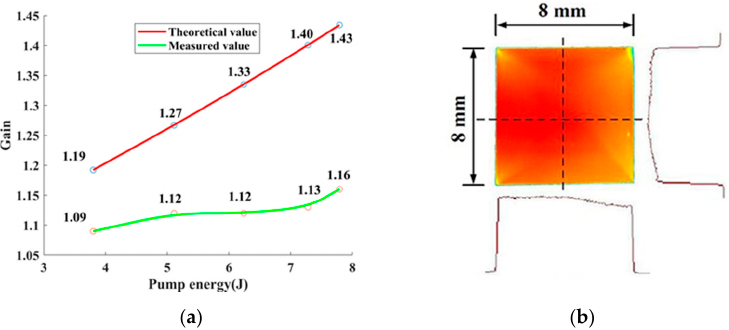
Figure 4. ( a ) Graph of theoretical and measured gain parameters of Nd-doped silica glass versus pump energy and ( b ) pump light intensity distribution.